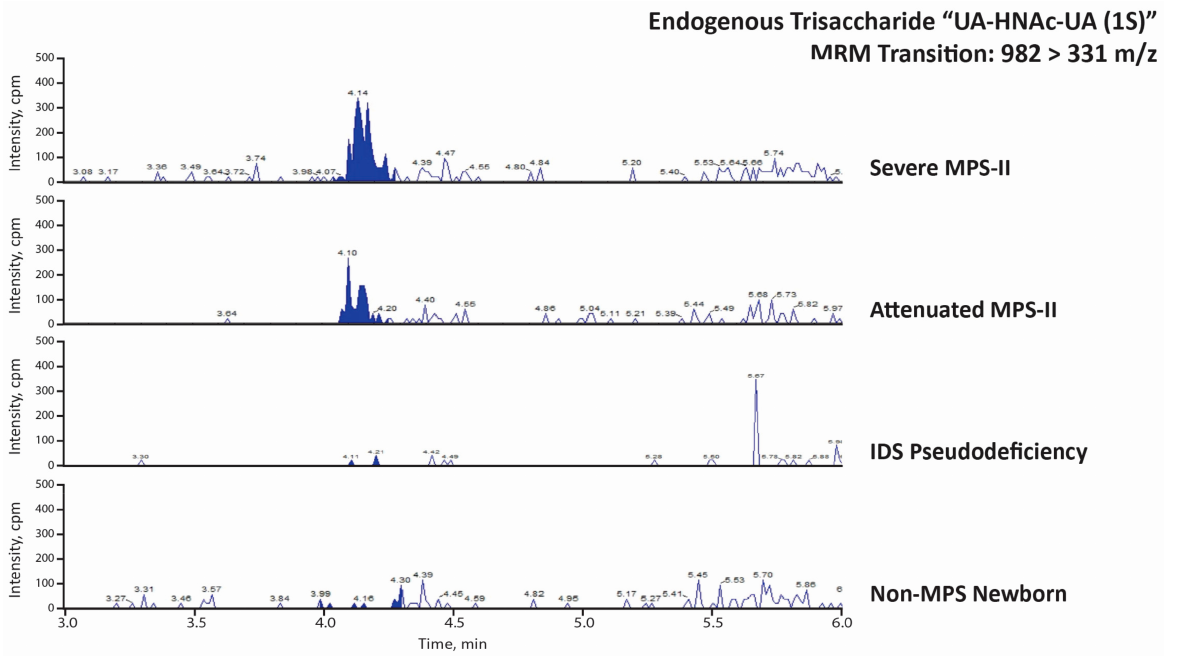
Figure 6. LC-MS/MS traces (MRM signal response versus time) for the PMP-derivatized endogenous trisaccharide marker UA-HNAc-UA (1S) (transition: 982 > 331 m / z ) using newborn DBS from indicated